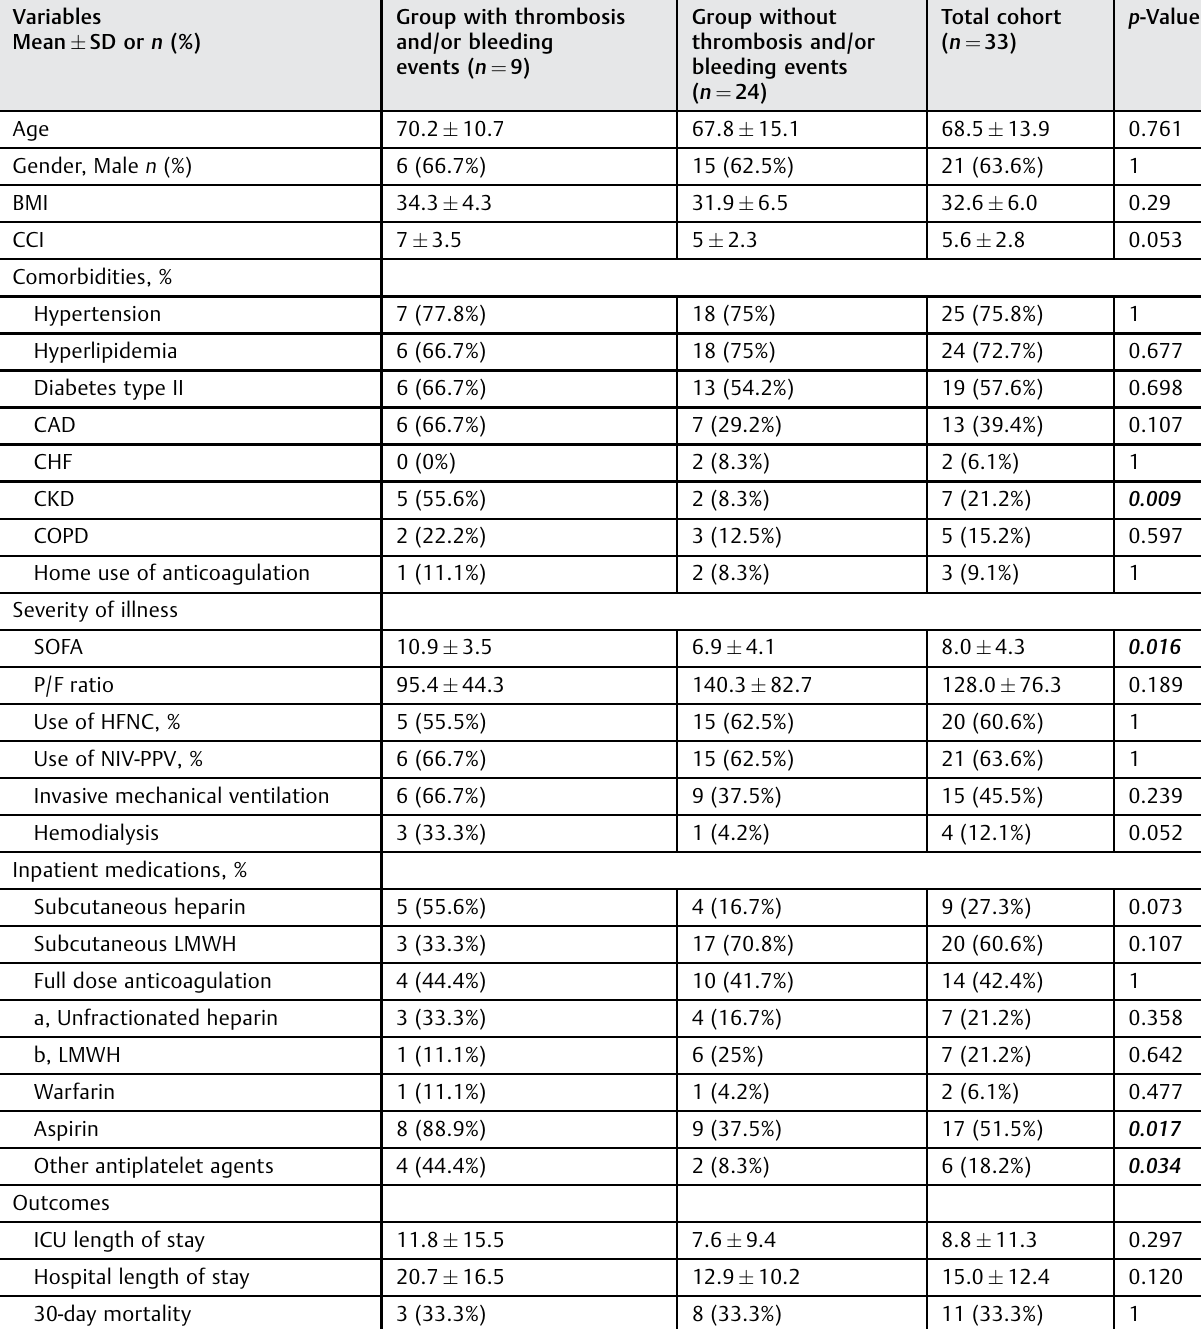
Table 1 Characteristics of groups with and without combined thrombosis and bleeding events Variables Mean (cid:3) SD or n